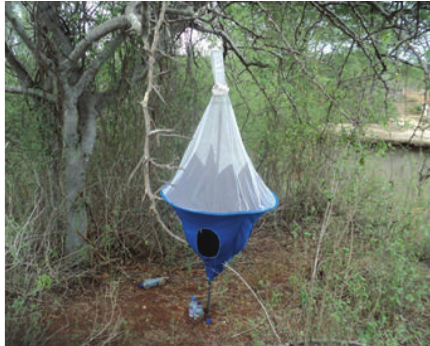
Figure 2: A biconical trap baited with cow urine and acetone to enhance trapping